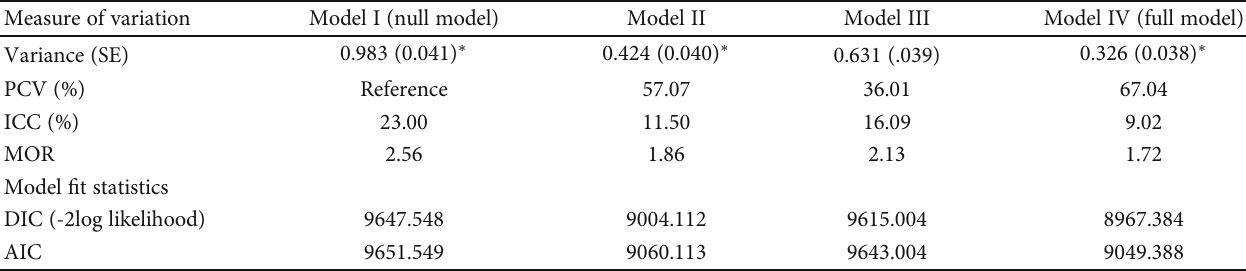
Table 3: Measure of variation on individual- and community-level factor associated with childhood diarrhea in Ethiopia, 2016. Measure of